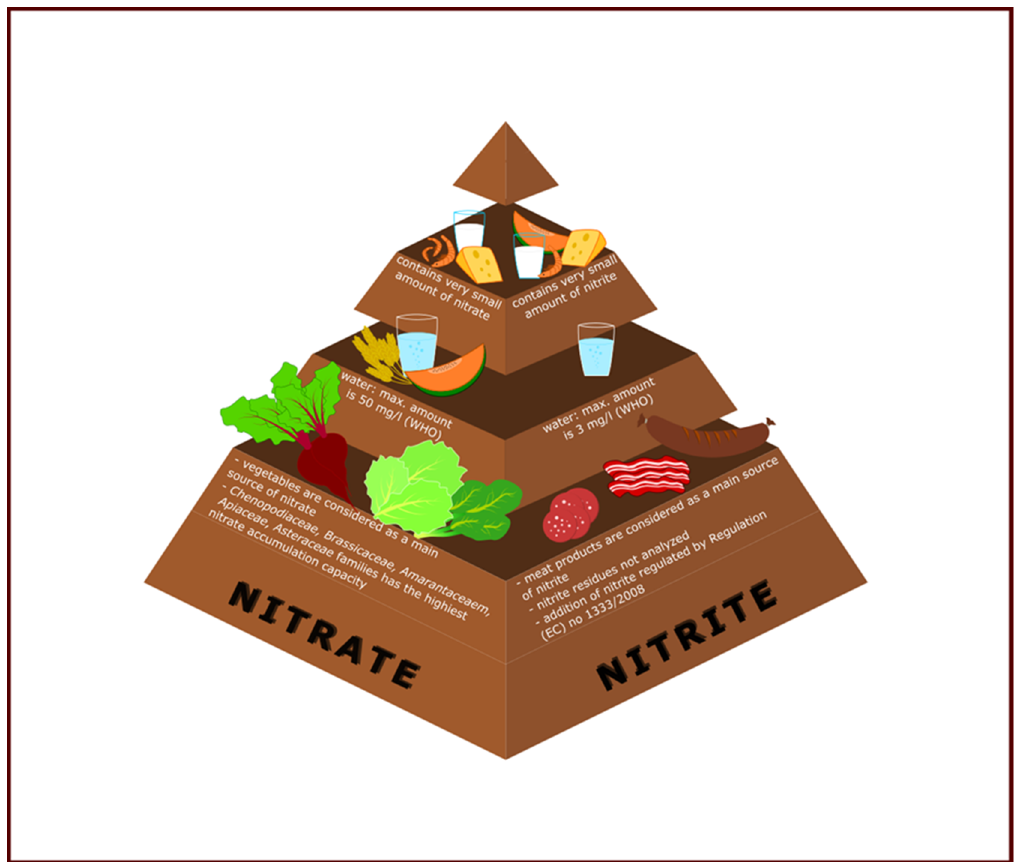
Figure 1. Main sources of nitrite and nitrate in various food’s type.